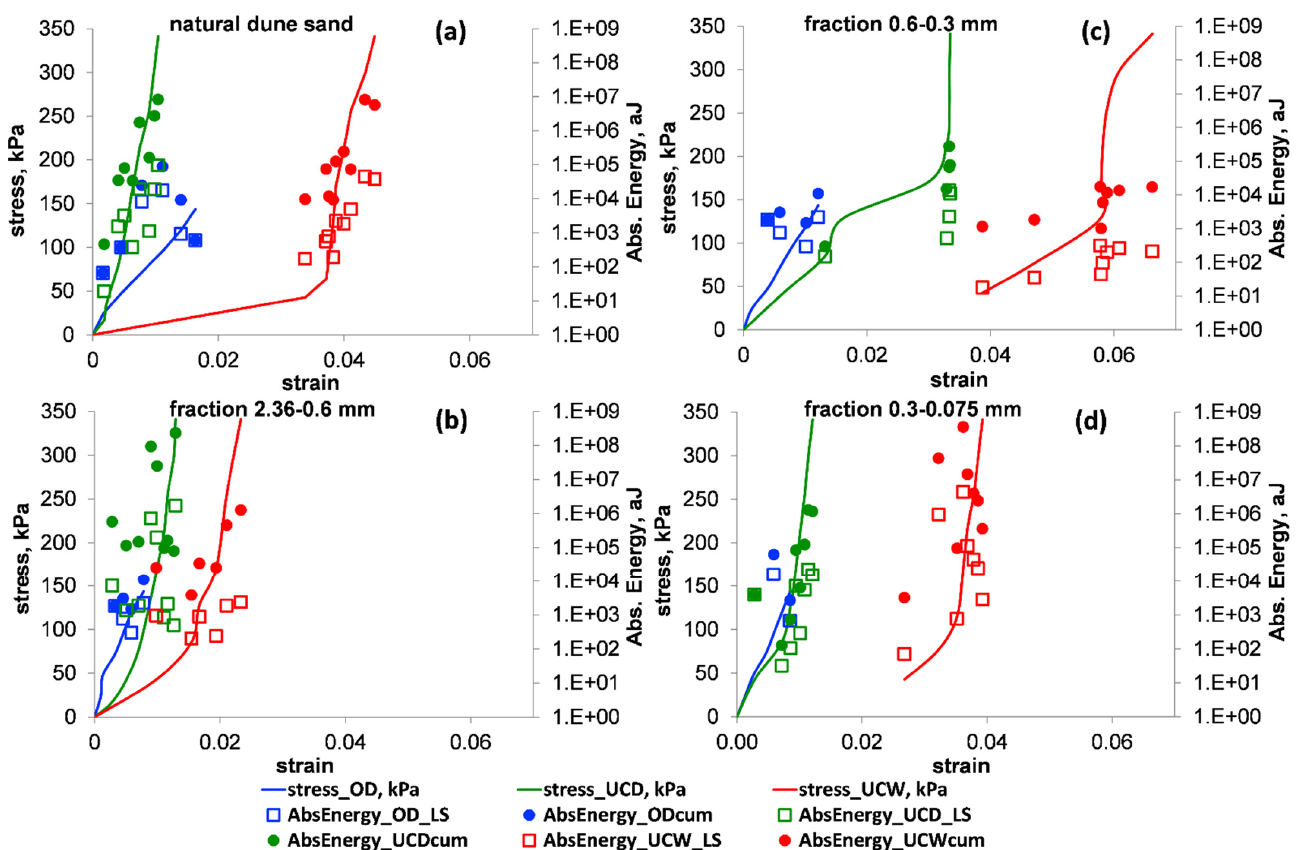
Figure 15. The stress–strain relationships (solid curves) vs. the values of the absolute energy (AbsEnergy) for the OD (blue), UCD (green) and UCW (red) tests. The empty squares and the full circles denote the values of the average (index = LS) and cumulative (index = cum) AbsEnergy for a loading stage, respectively. Panels ( a – d ) show the results for natural dune sand and its three extracted fractions: 2.36–0.6, 0.6–0.3 and 0.3–0.075 mm, respectively. Note that in the used number format, the notation “E ± xx” is part of a scientific notation and corresponds to “ · 10 ± xx ”. Table 1. Summary of AE measurement results. For the interpretations of the +, -, +/- and -/+ symbols, refer to the main text. Average Value of the Parameter Cumulative Value of the Parameter Parameter for a Loading Stage for a Loading Stage (Sensitivity to Stress Level) (Sensitivity to Stress Level) OD UCD UCW OD UCD